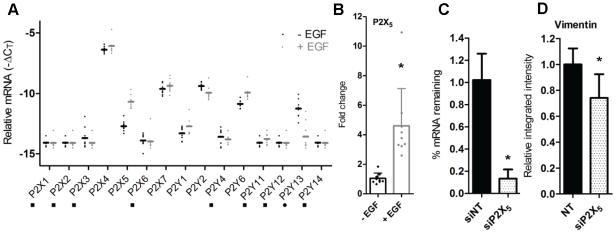
Effect of EGF on the transcriptional profile of purinergic receptors in MDA-MB-468 cells.Serum deprived MDA-MB-468 cells were treated with EGF or control for 12 h prior to RNA isolation and real-time RT-PCR analysis. A, −ΔCT values of all P2 receptors studied. Samples with a CT outside the limit of detection were assigned a value of 35 (▪ signifies target registered above the limit of detection (CT>35) in one or more samples for both EGF and control treatments; • denotes target was above the limit of detection in EGF samples only). B, Quantitation of alterations in P2X5 mRNA following EGF treatment (12 h). C, Knockdown efficiency of P2X5 siRNA (siP2X5) relative to the non-targeting control (siNT) was assessed using real time RT-PCR; representative of 5 wells from 3 independent experiments. D, EGF-induced vimentin protein expression (IF) in MDA-MB-468 cells treated with siNT or siP2X5. Results are representative of 9 wells from 3 independent experiments (unless otherwise specified) and are shown with S.D. (* P<0.05, unpaired t-test).